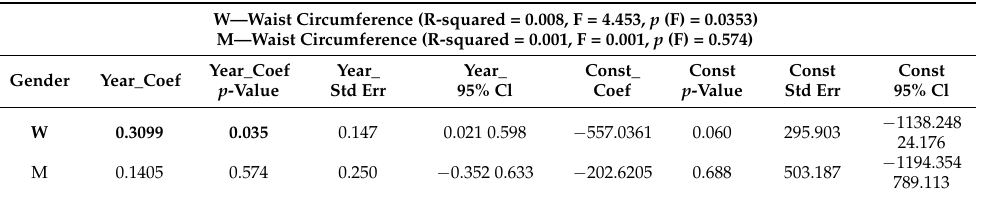
Table 6. The numerical characteristics of the temporal changes in the waist circumference of women and men in the decade 2011–2020.